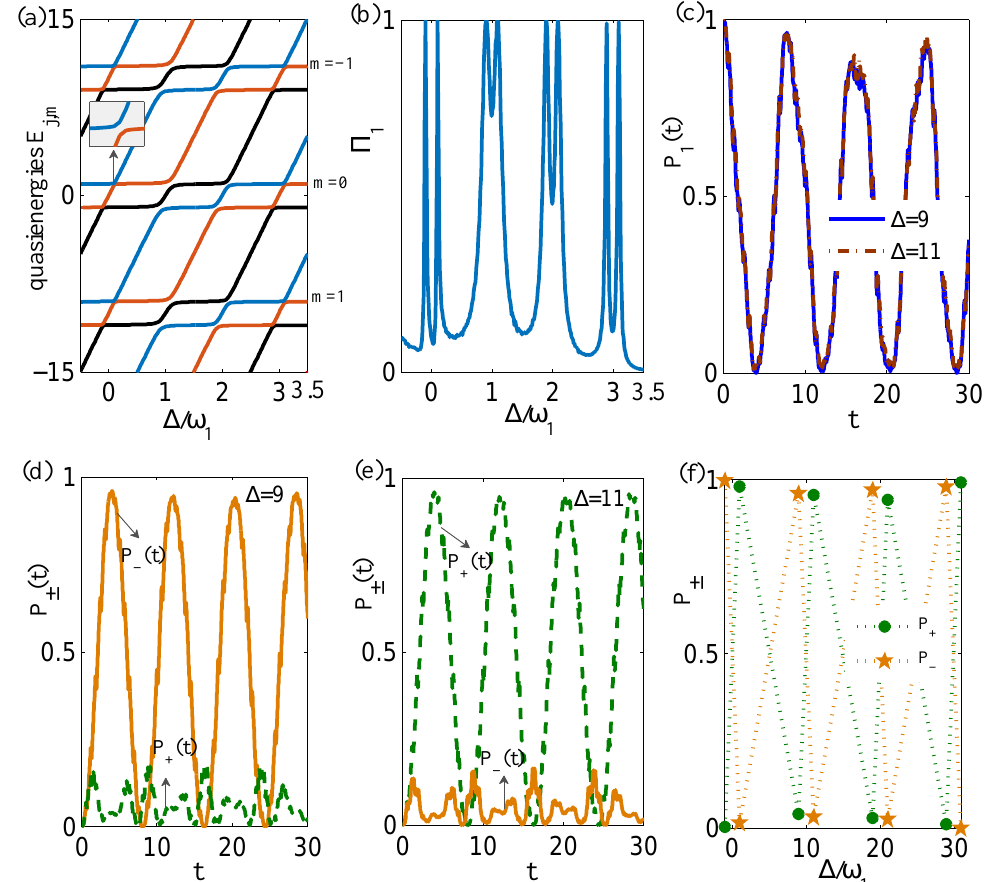
Figure 2. (Color online) ( a ) Floquet quasienergies and ( b ) Π 1 as a function of ∆ / ω 1 show pairs of avoided crossings and photon-assisted tunneling. ( c ) Evolution of occupations at well 1 P 1 ( t ) = | a 1 ( t ) | 2 for two cases of ∆ = 9 and ∆ = 11. ( d , e ) Evolution of occupations at the sym- metrical state P + ( t ) and anti-symmetrical state P − ( t ) for ( d ) ∆ = 9 and ( e ) ∆ = 11. ( f ) Population probabilities P + and P − corresponds to the avoided crossings. The values are derived when P